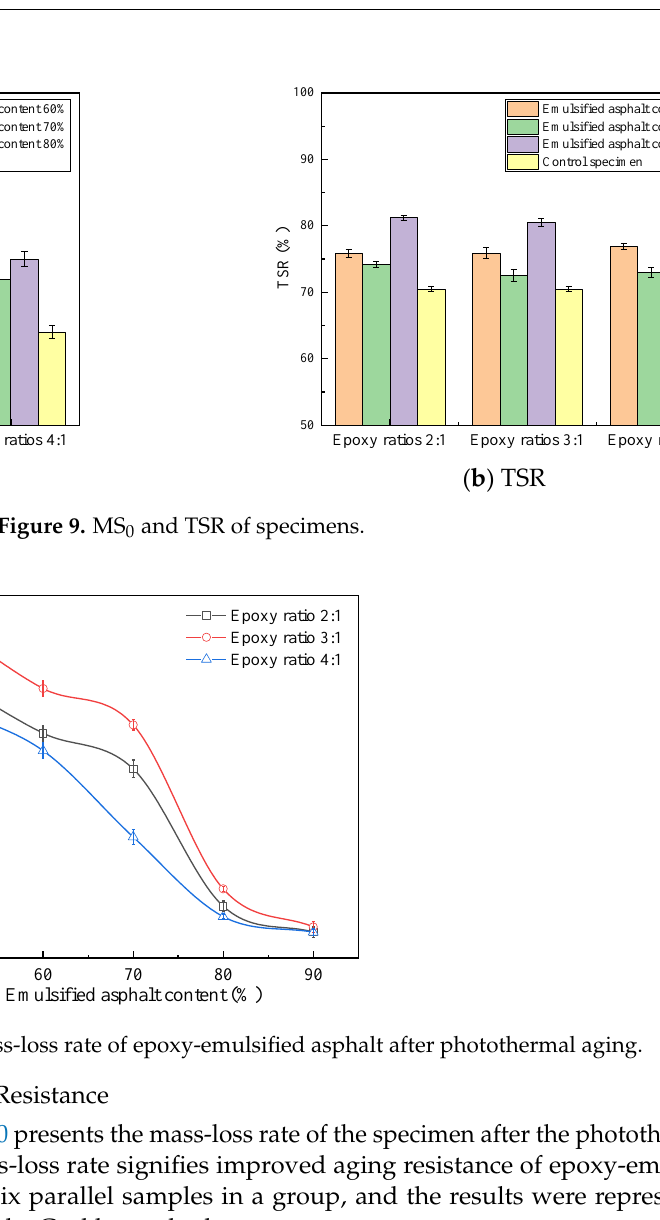
Figure 10. Mass-loss rate of epoxy-emulsified asphalt after photothermal aging.